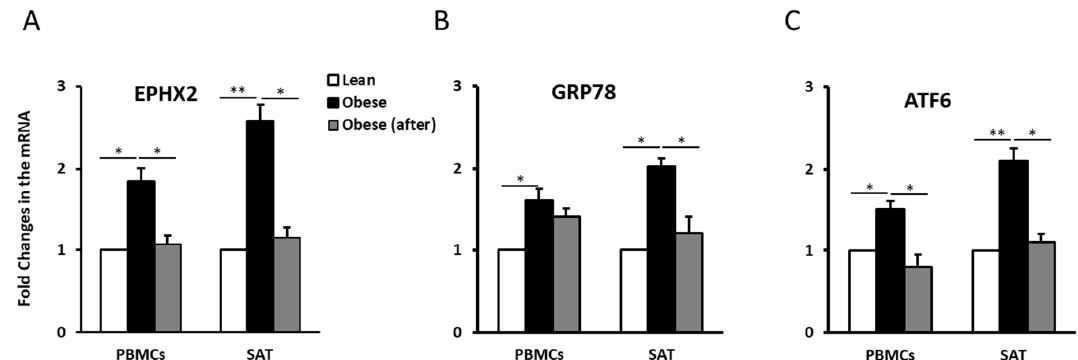
Figure 1. Epoxide hydrolase 2 (EPHX2) mRNA expression in subcutaneous adipose tissue (SAT) and